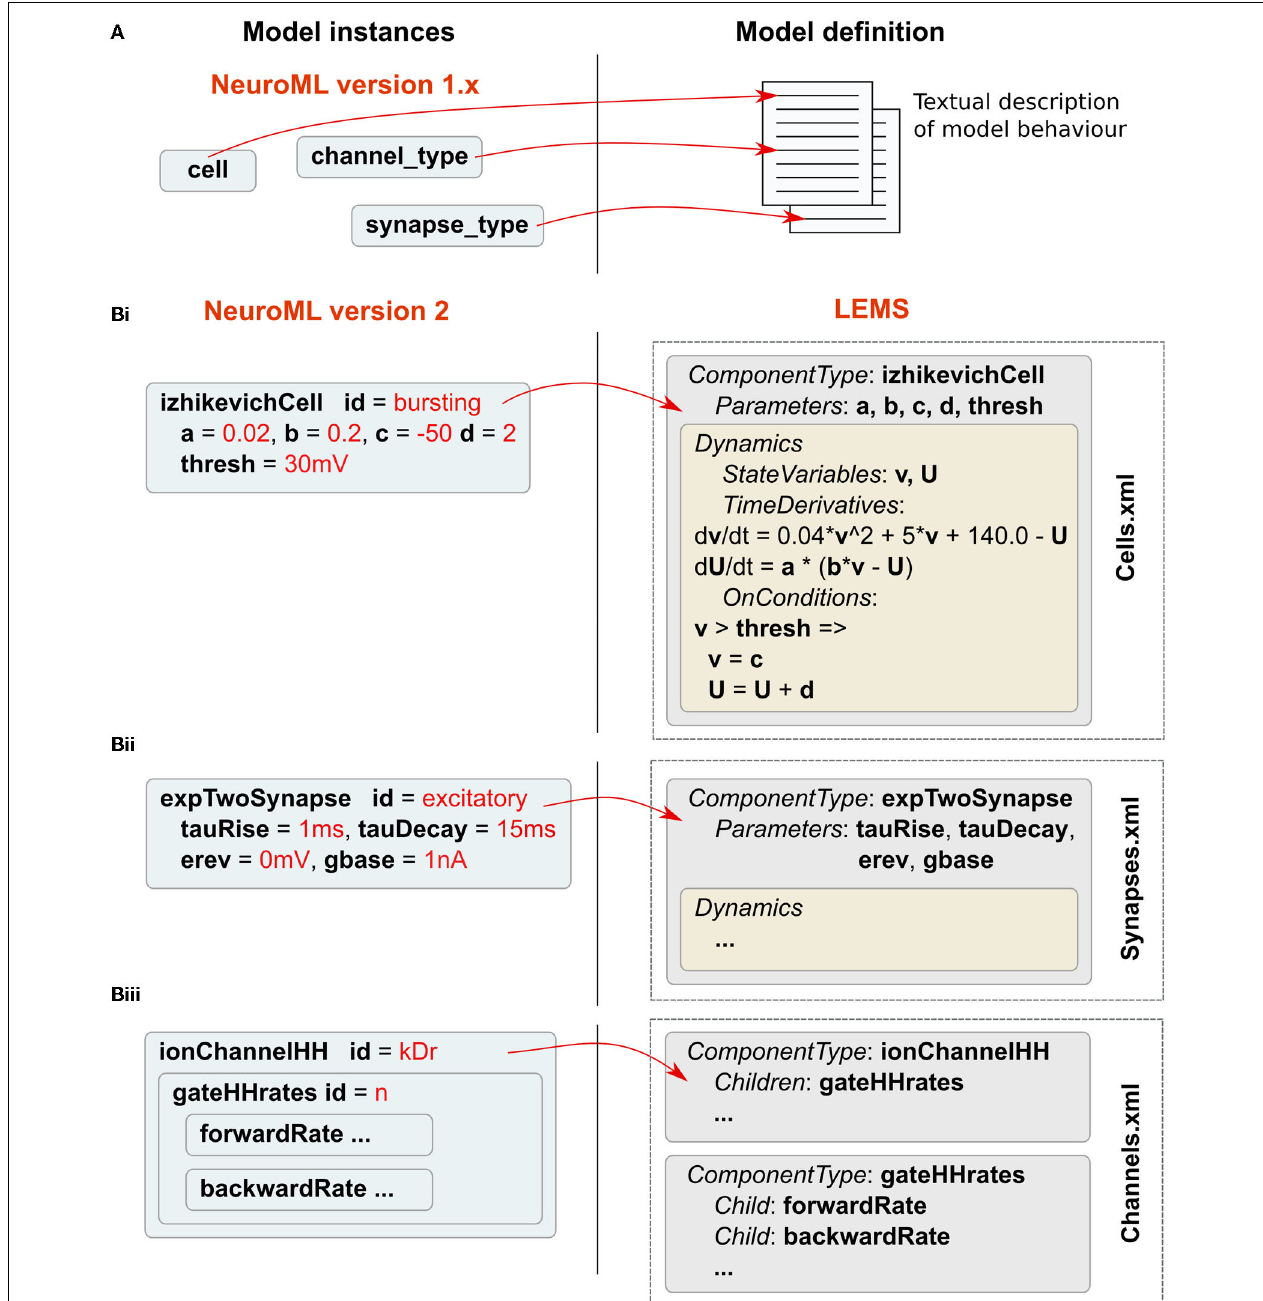
FIGURE 2 | Relationship between NeuroML v2 and LEMS. (A) Model definitions in NeuroML v1.x are specified as textual descriptions in human-readable documentation. (B) In NeuroML v2, components have a corresponding structural and mathematical definition in LEMS. A number of examples of ComponentTypes in LEMS are shown. A ComponentType izhikevichCell is defined in LEMS (i), and its parameters are specified as a, b, c, d, and thresh . The Dynamics of the ComponentType defines the state variables v and U . LEMS specifies how these vary with time. Conditions such as when the membrane potential crosses firing threshold are also defined